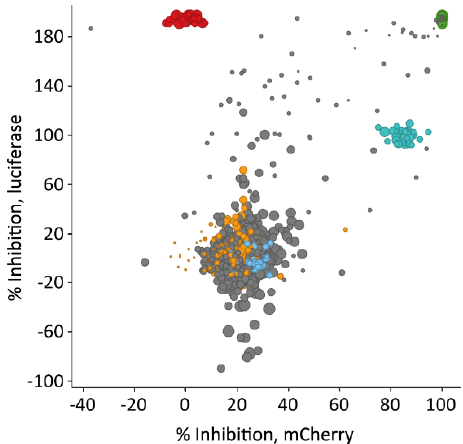
Figure 2. Luciferase-based proof-of-concept screen. Comparison of luciferase-based and mCherry- based wild-type reverse transcriptase data set. Data on the y -axis show luciferase inhibition. Data were normalized to AZT-treated wells, set to 100%, and DMSO-treated wells, set to 0% inhibition. Cells not expressing luciferase are at 200% inhibition, as AZT is reducing the signal by 50%. Color coding is as Figure 1: Transduced DMSO-treated wells in orange, transduced compound-treated wells, which were screened in both setups, in grey, transduced AZT-treated wells in turquoise and mCherry-only transduced cells in red, eGFP-positive cells shown in green. Viability is illustrated by the datapoint size.